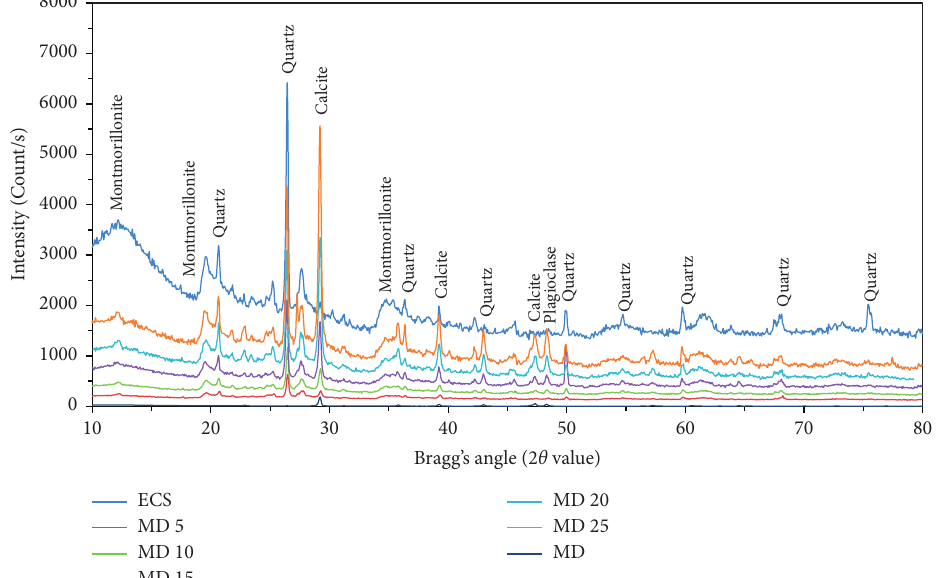
Figure 16: XRD analyses of MD, raw soil, and raw soil-MD